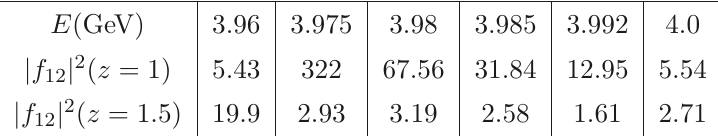
2 near the Σ D threshold. f 12 ( E ) | |